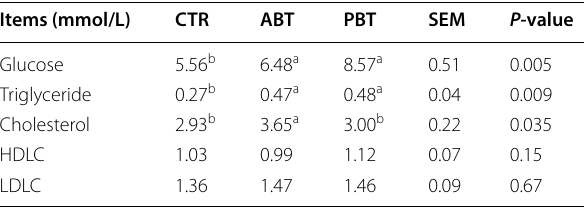
Table 3 Effects of dietary B. subtilis supplementation on serum parameters of piglets